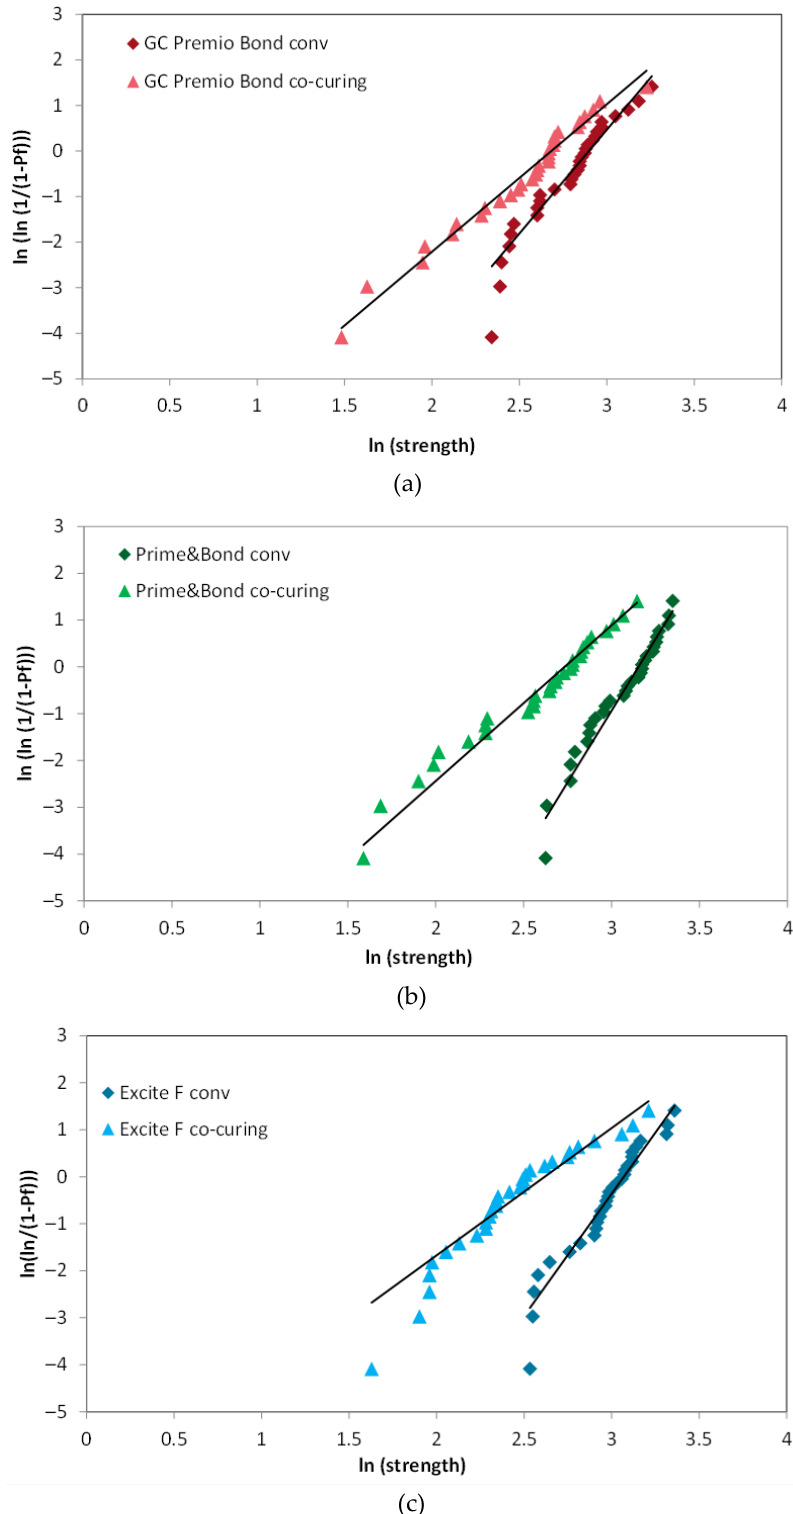
Figure 4. Weibull diagrams for the conventional and co-curing method of application for all three adhesive systems used in the study. Slopes of the fit lines represent Weibull modulus. (a) GC Premio Bond, (b) Prime&Bond, (c) Excite F.